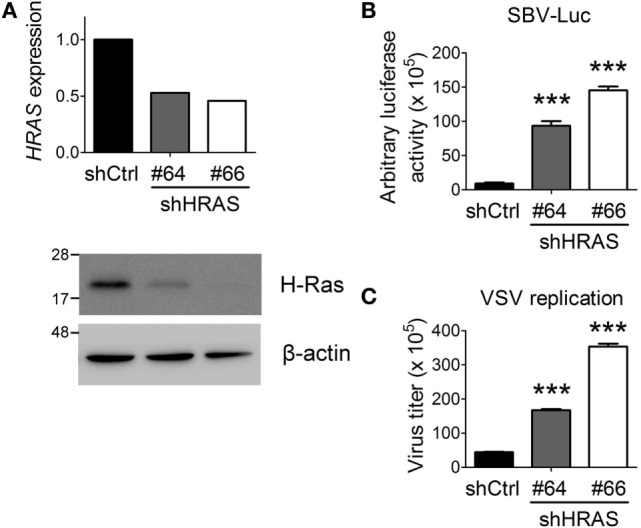
H-Ras depletion enhances the replication of two RNA viruses. (A) H-Ras in HEK293T cells was depleted by two independent lentiviral clones, shHRAS#64 and shHRAS#66, which contained shRNAs targeting HRAS. RT-qPCR and Western blot were performed to validate the knockdown efficiency of these two shRNAs. (B) HEK293T cells were treated with lentiviruses containing control shRNA (shCtrl) or shHRAS#64 or #66 for 4 days. The cells were then infected with a recombinant Sindbis virus containing a luciferase gene (SBV-Luc) at a multiplicity of infection (MOI) of 30. The expression of the luciferase gene was under the control of a subgenomic RNA promoter, which is relied on viral replication. Luciferase activity was measured at 48 h post SBV infection. (C) The HEK293T cells depleted of H-Ras by shHRAS#64 or #66 were infected with vesicular stomatitis virus (VSV) at an MOI of 0.001. The medium was harvested at 24 h post-viral infection, and the VSV titer in the supernatant was determined by plaque assays on Vero cells. All data are presented as the mean ± SD of triplicate samples from one representative of at least three independent experiments. ***P < 0.001 between the indicated groups and the control shRNA-treated group (one-way ANOVA followed by Dunnett’s post hoc analysis).